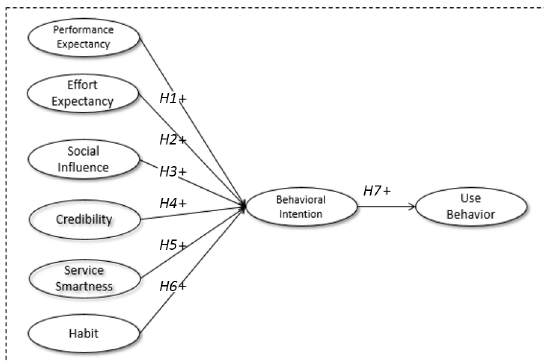
Figure 1. Proposed research